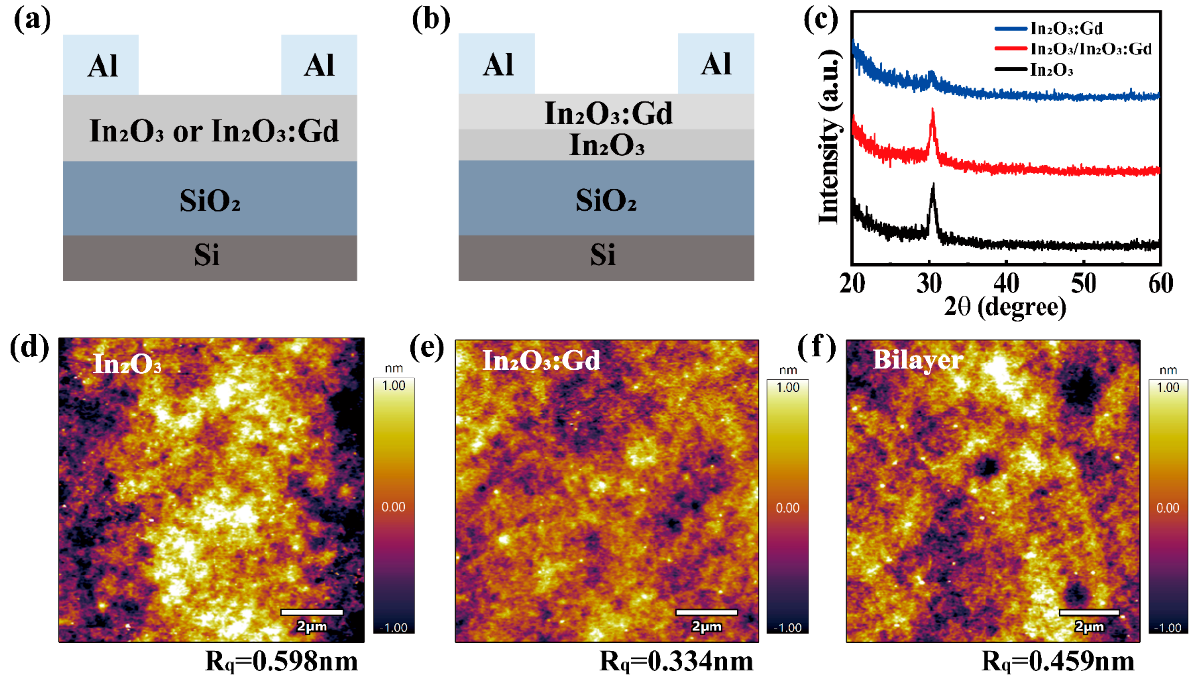
Figure 1. Schematic cross-sectional view of ( a ) the In 2 O 3 or InGdO and ( b ) the In 2 O 3 /InGdO heterojunction TFTs. ( c ) XRD patterns of the In 2 O 3 , InGdO, and In 2 O 3 /InGdO thin films annealed at 300 °C. AFM surface morphology of ( d ) In 2 O 3 ( e ) InGdO ( f ) In 2 O 3 /InGdO thin films annealed at 300 °C.